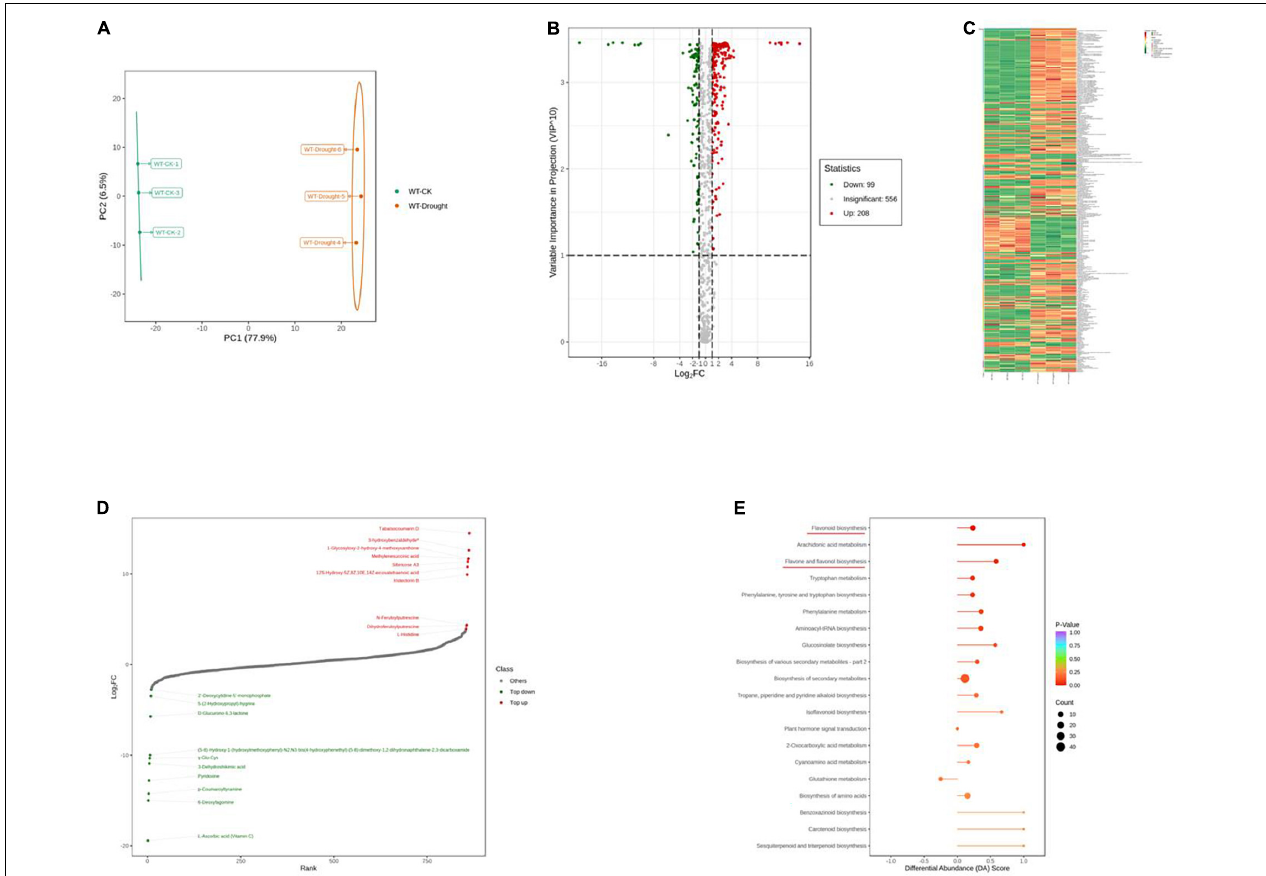
FIGURE 7 | Qualitative and quantitative analyses of differentially expressed metabolites in WT plants after drought stress. (A) PCA score plots for the mass spectra data of WT and OE samples. The abscissa represents the first principal component (PC1), while the ordinate represents the second principal component (PC2). (B) Volcano plot of differentially expressed metabolites between WT and OE plants. The abscissa represents the contents of differentially expressed metabolites between the two samples; a greater absolute value of the abscissa indicates a greater difference in relative content. A larger ordinate value indicates a more credible difference. Red scatter indicates metabolites that were significantly upregulated; green scatter indicates metabolites that were significantly downregulated; gray scatter indicates metabolites with no significant difference. (C) Clustering analysis of the metabolome data from WT and OE plants. Heatmap representation of the levels of differentially expressed metabolites and the color indicated low (green) to high (red). Each line in the heatmap represents a metabolite. Ten classes were evident after the clustering analysis. (D) The top 10 upregulated and downregulated metabolites between WT and OE plants. Red dots represent upregulated metabolites; green dots represent downregulated metabolites. (E) KEGG enrichment analysis of differentially accumulating metabolites between WT and OE samples. DA score represents the overall changes in all metabolites in the metabolic pathways; a score of 1 indicates upregulated trend, while a score of –1 indicates a downregulated trend. Each bubble in the plot represents the number of associated metabolites; P- values are indicated by